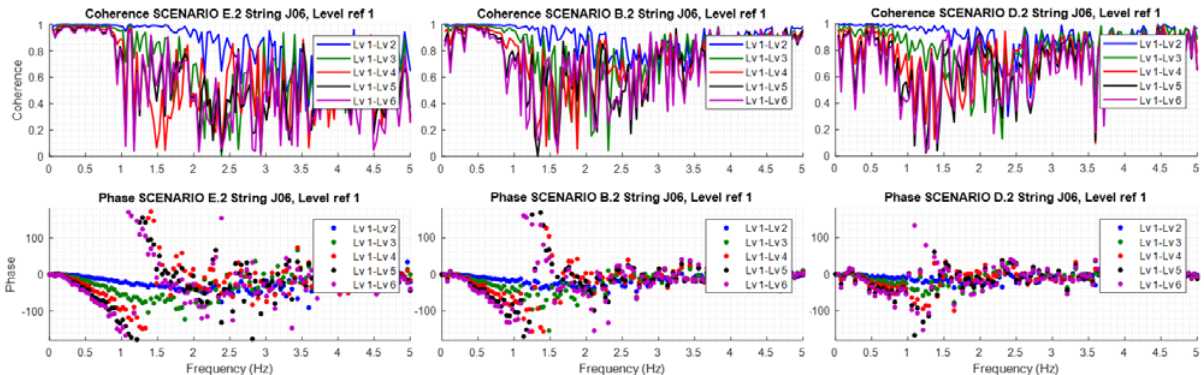
Figure 5: From left to right coherence and phase functions of Scenarios E.2 ( ∆∆ F ±1 %, ∆∆TT ±3 ºC), B.2 ( ∆∆ F ±1 %, ∆∆T ±1 ºC) and D.2 ( ∆ F ±3 %, ∆T ±1 ºC). in all cases random vibrations with amplitude of 1